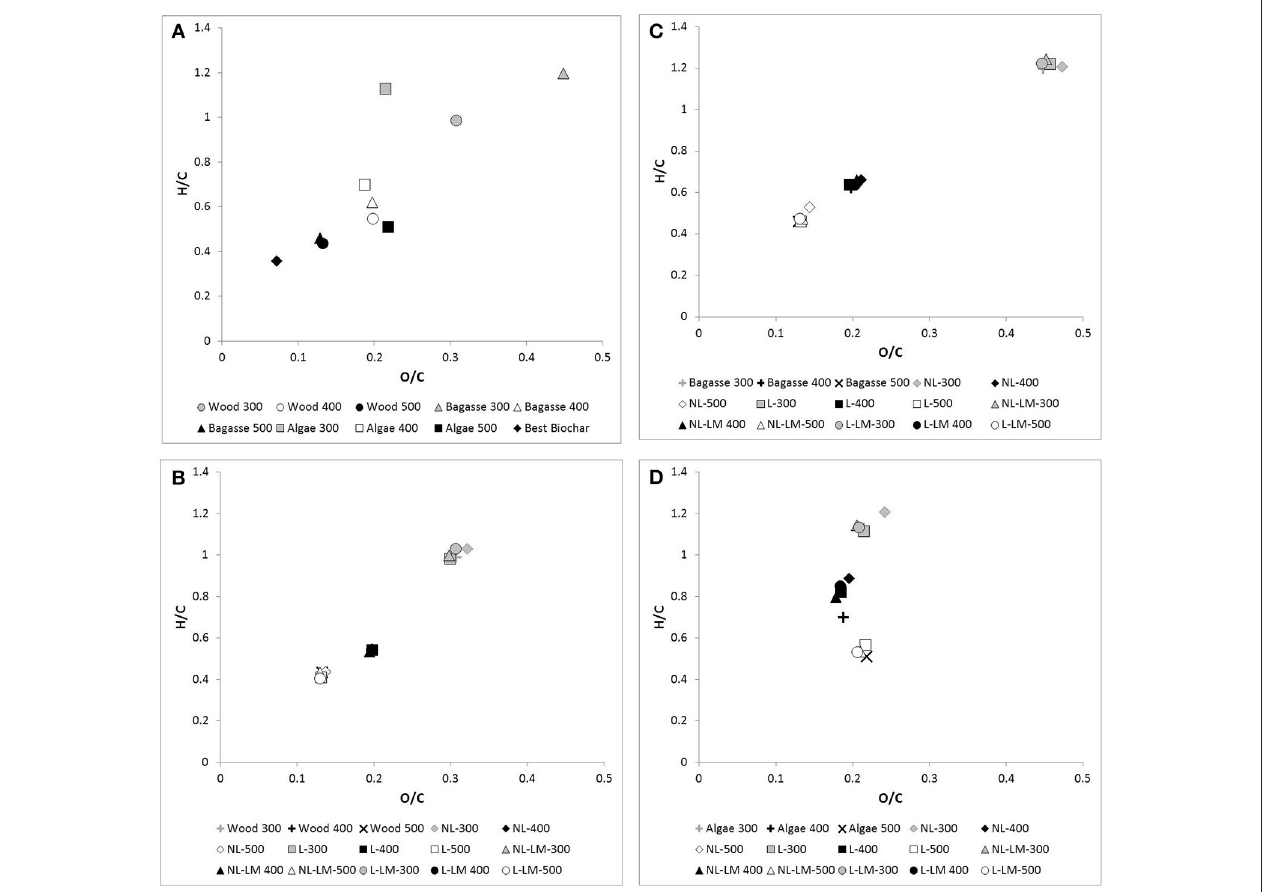
FIGURE 2 | O/C and H/C ratios of samples (Gray symbols, 300 ◦ C PyC; White symbols, 400 ◦ C samples; Black symbols, 500 ◦ C samples). (A) shows samples before environmental exposure: Circles, Nothofagus wood biochar; Triangles, S. officinarum biochar; Squares, C. vagabunda algae biochar; Diamonds, BEST Biochar. (B) ( Nothofagus wood biochar), (C) ( S. officinarum biochar), and (D) ( C. vagabunda algae biochar) show biochar before and after environmental exposure: Crosses, original biochar; Diamonds, treatment NL; Squares, treatment L; Triangles, treatment NL-LM; Circles, treatment